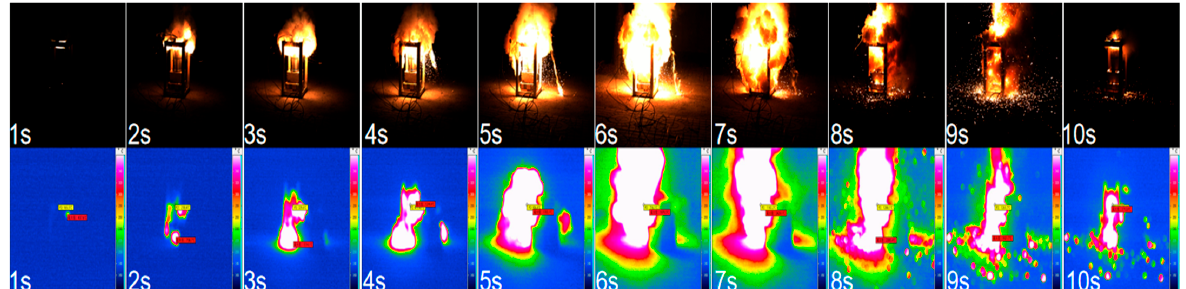
Figure 3. The high-speed camera and infrared camera images of the heat flow growth process of Test 3.